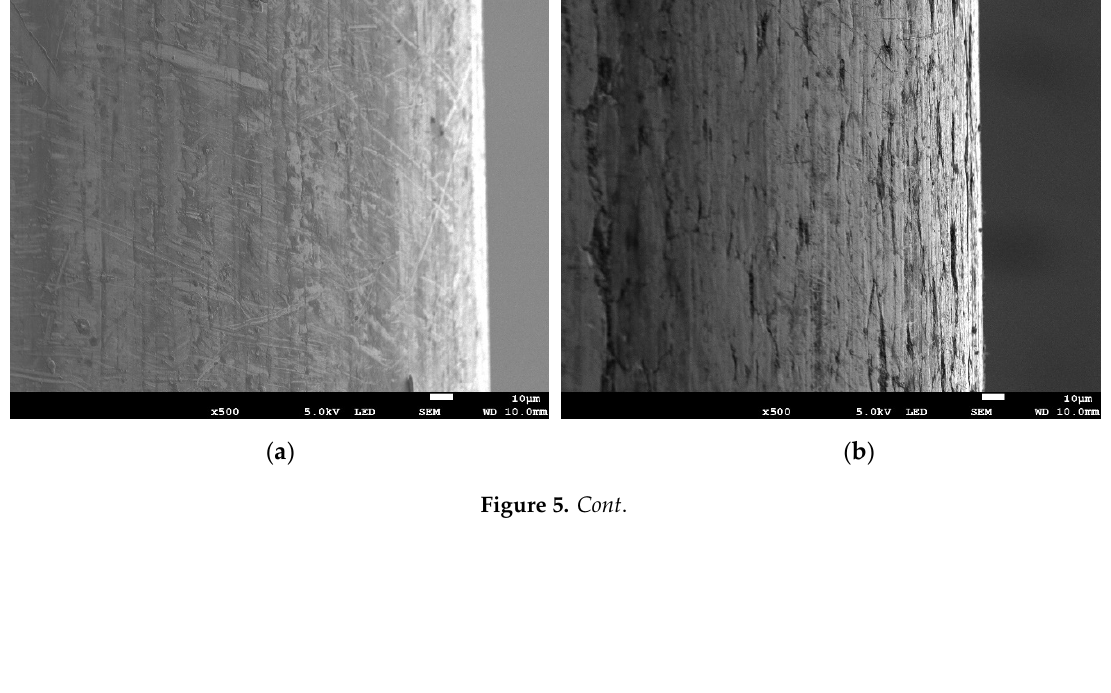
Figure 4. The surface layer of wire after storage: ( a ) A wire stored in Gdańsk welding site (GWS); ( b ) A wire stored in Mońki agricultural building (MAB); ( c ) B wire stored in Gdańsk welding site (GWS); ( d ) B wire stored in Mońki agricultural building (MAB).